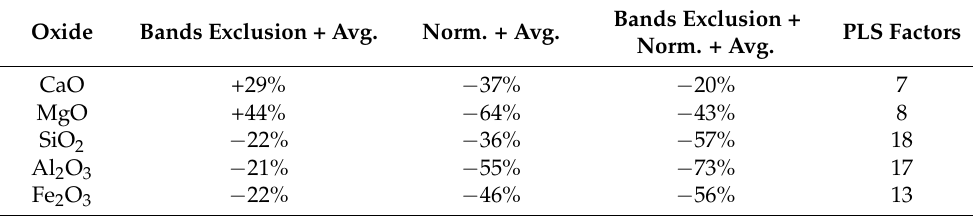
Table 1. Relative variation of RMSECV in PLS models when using different data treatments with respect to averaging spectra only. Positive and negative values represent an increase and decrease in the RMSECV,